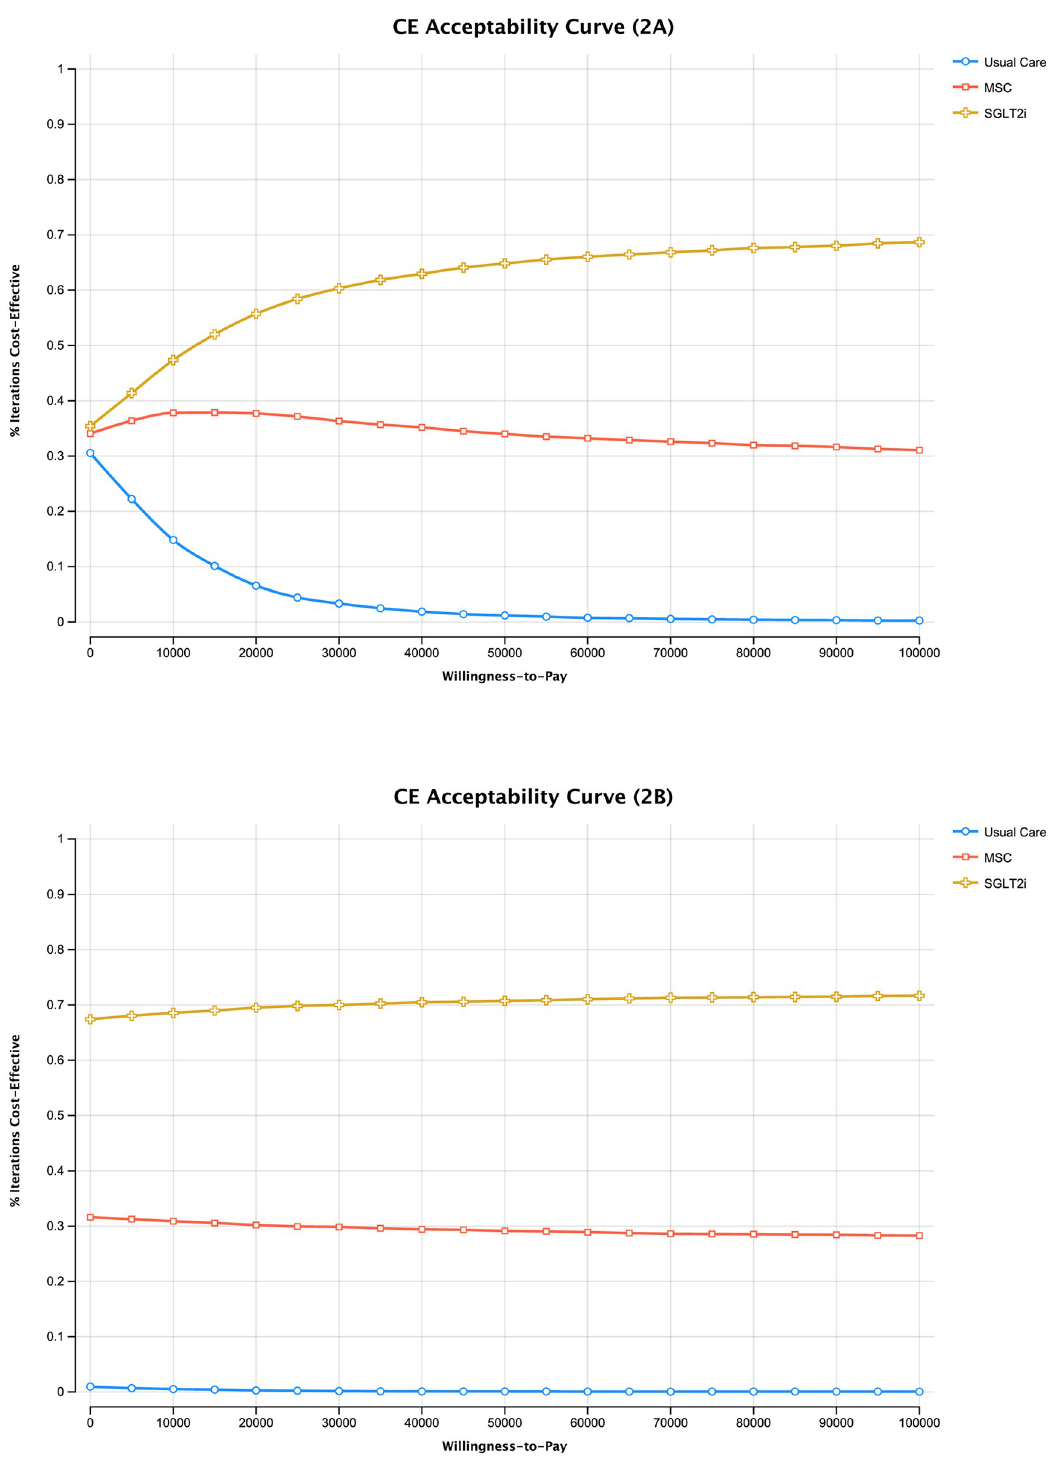
Fig 2. Cost-effectiveness acceptability curve displaying the probability of each treatment (SGLT2i, MSC, Usual Care) being cost-effective at different willingness-to-pay thresholds for those aged 71 years at baseline (2A) and those aged 40 (2B).